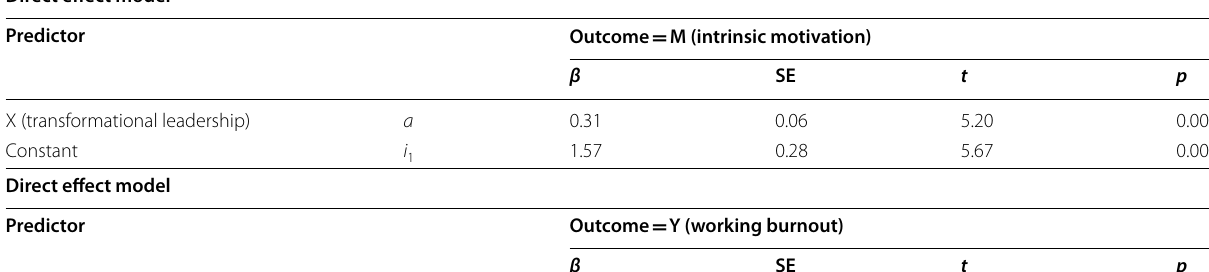
Table 5 Results of simple mediation model for working burnout